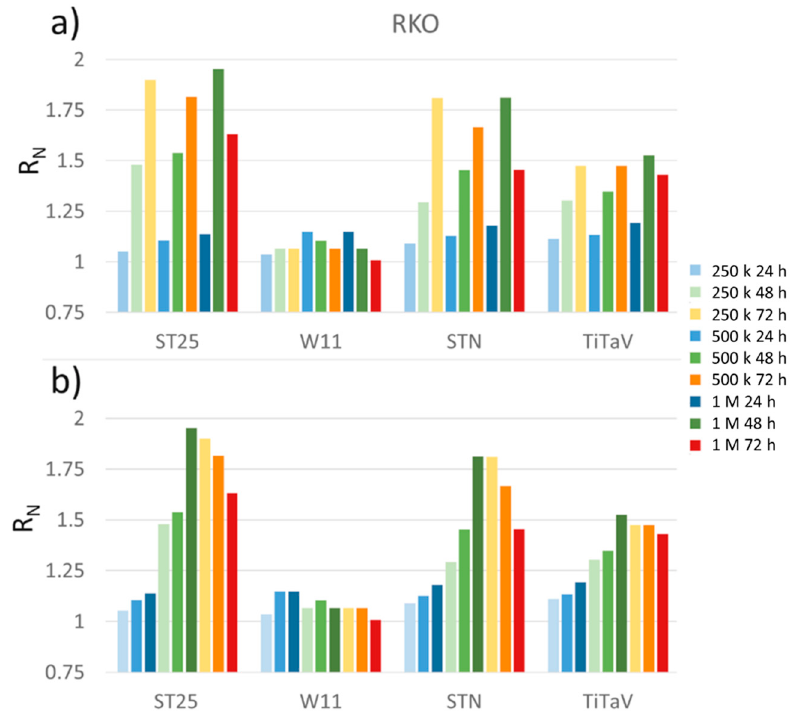
Figure 8. Sensor responses to RKO cell line. Cells plated at 250 K (light colors), 500 K (medium dark colors), and 1 M (dark colors) cells/dish, measured after being withdrawn from the incubator at 24 h (blue), 48 h (green), and 72 h (orange); ( a ) cells sorted for the same concentration at different times of incubation; ( b ) cells sorted for the same time of incubation but at different concentrations.